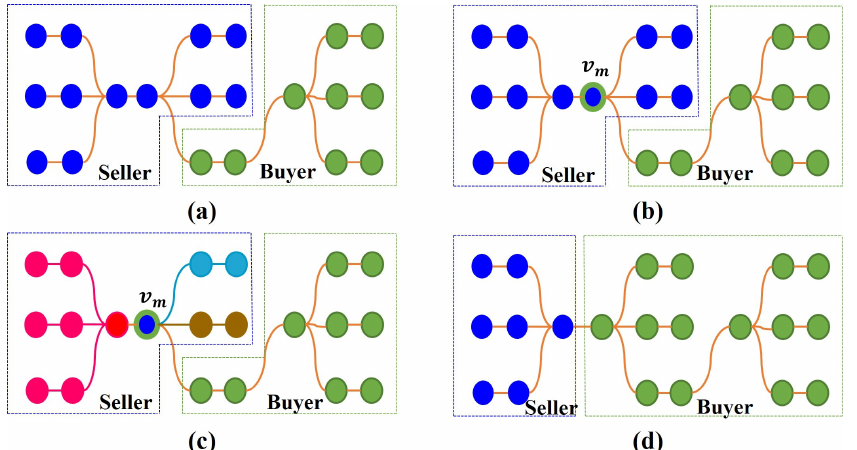
Figure 7. An example of the tree-partition strategy. ( a ) The graphs of the seller and buyer. ( b ) The adjacent vertex v m . ( c ) Three sub-trees with the root v m in the seller. ( d ) The buyer and seller after the task